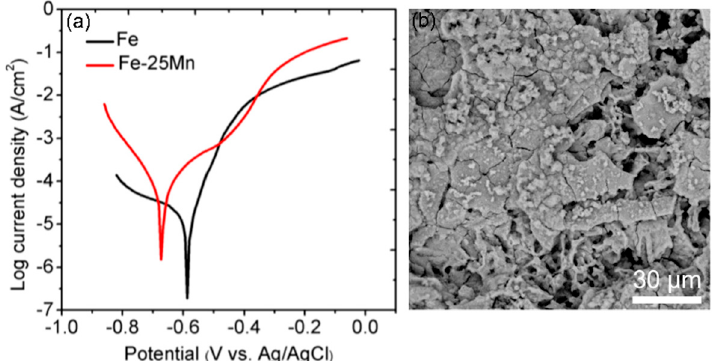
Figure 29. High Mn steel produced via SLM: ( a ) Potentiodynamic polarization curve in simulated body fluid, and ( b ) SEM micrography of the corroded specimen after polarization [225].